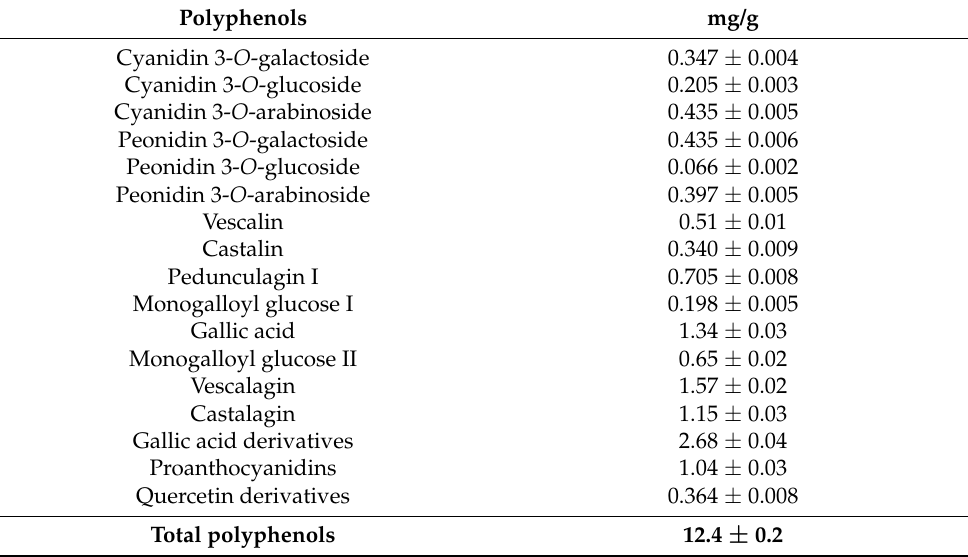
Table 1. Polyphenol content in the tested OFS. Results in mg/g powder, with absolute